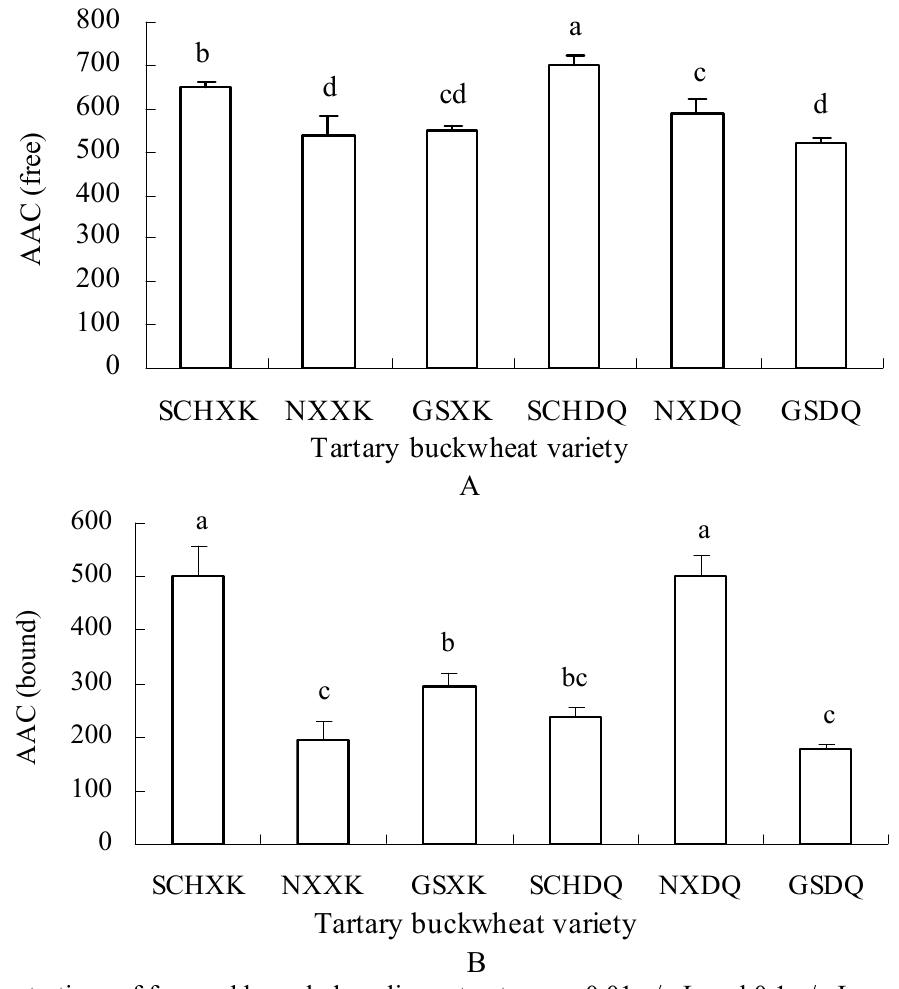
Figure 3. Antioxidant activity coefficient (AAC) of free (A) and bound (B) phenolics of two tartary buckwheat varieties grown at three